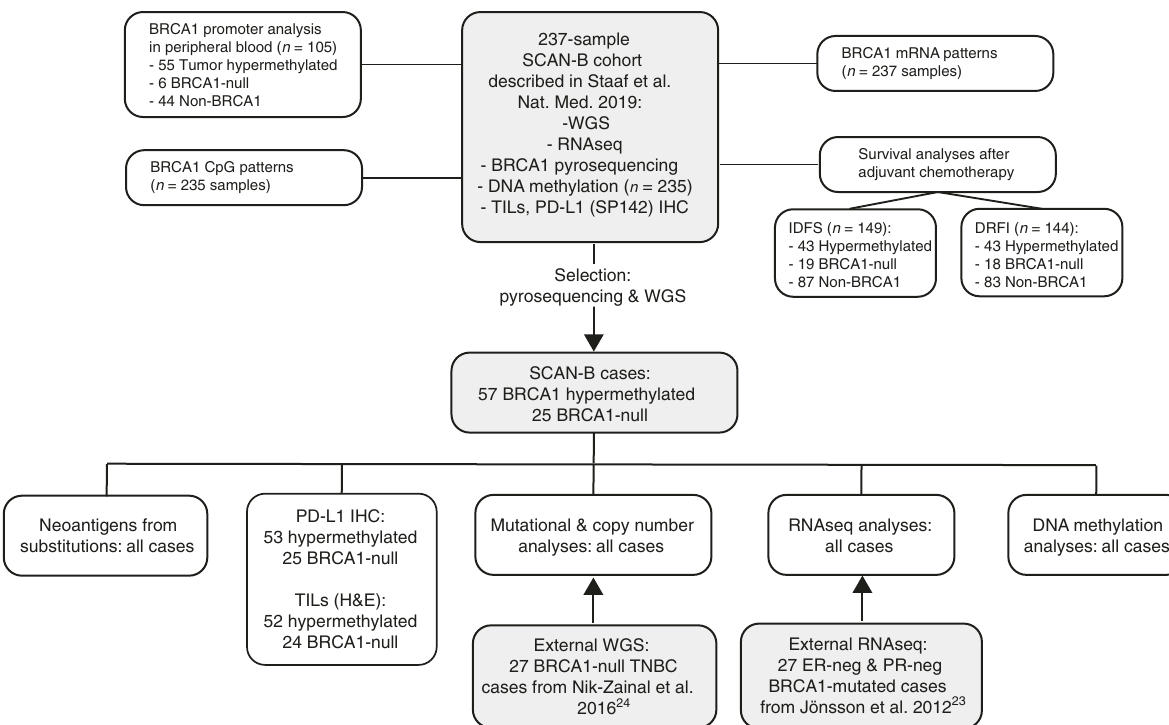
Fig. 1 Study scheme, performed analyses, and cohorts used. Gray boxes indicate a cohort of